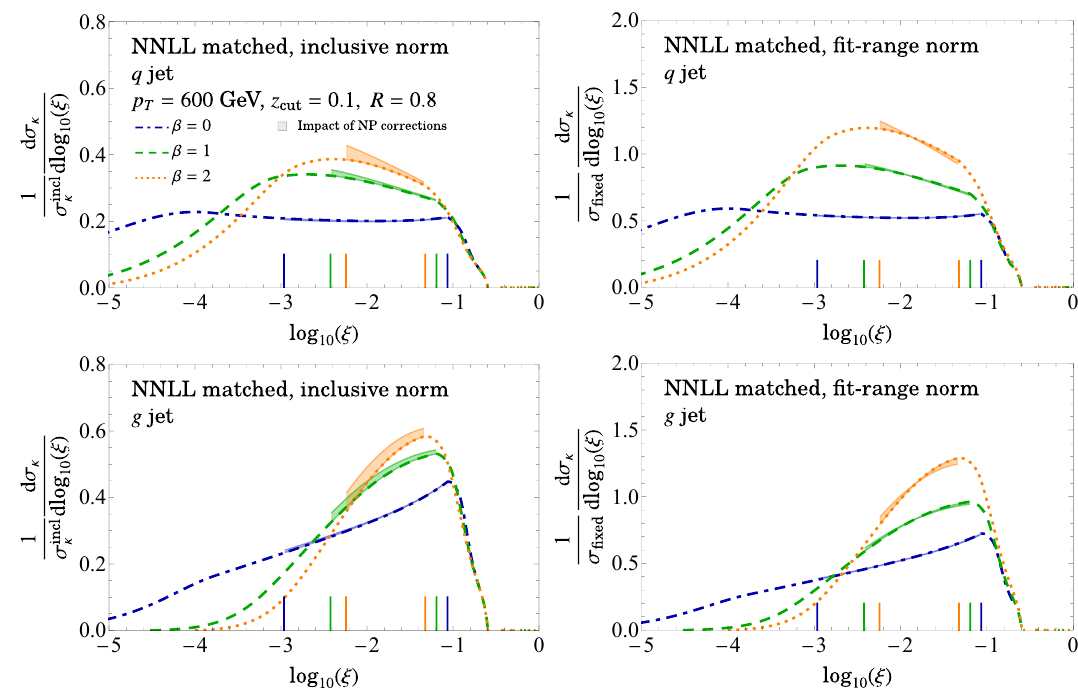
Figure 11 . The dependence of the cross section on nonperturbative parameters. The start and end points of the fit range are indicated with vertical